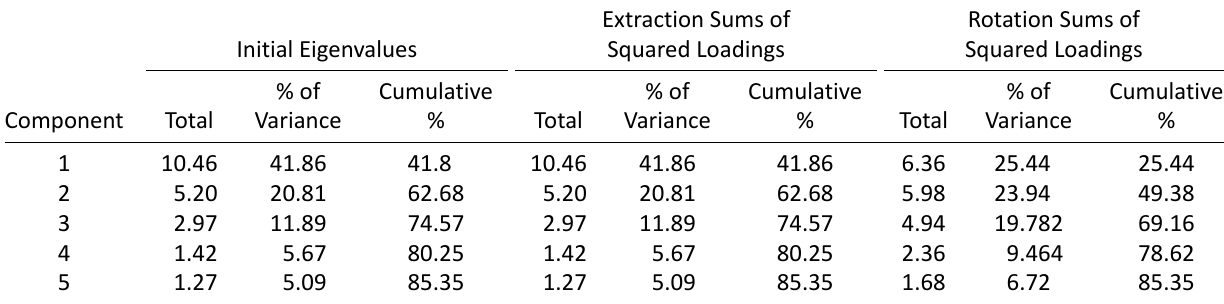
Table 6. Total variance of the principal components explained.